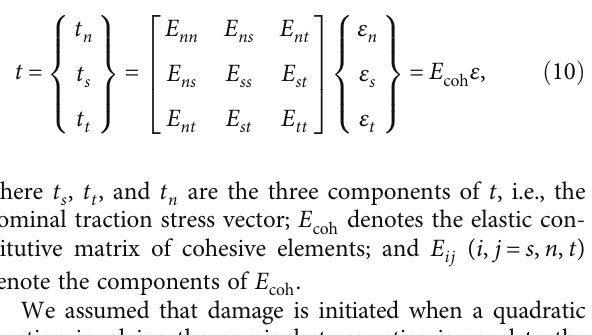
Figure 3: Matching the results of fi nite element numerical solution with lab tests conducted by Sierra et al. [33], which will be the input parameters used for analysis in the remaining